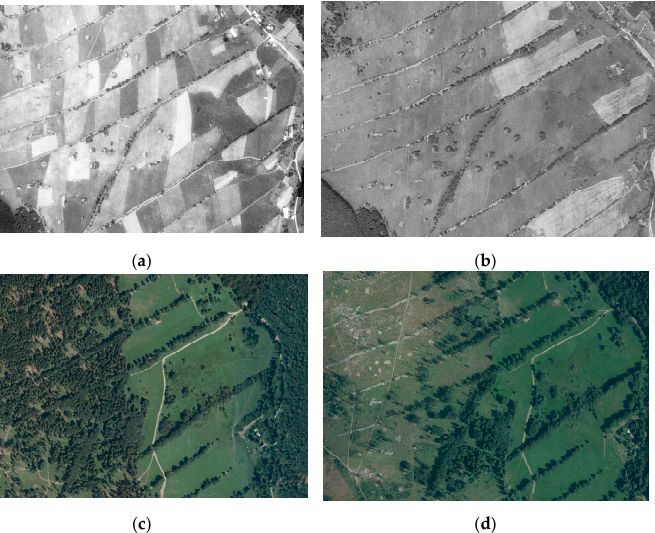
Figure 5. Agrarian stone walls, Ztracená Voda (Verlorenwasser), district of Bruntál. The year: ( a ) 1937, ( b ) 1955, ( c ) 2016, and ( d ) 2020 (source: https://ags.cuzk.cz/archiv (accessed on 10 November